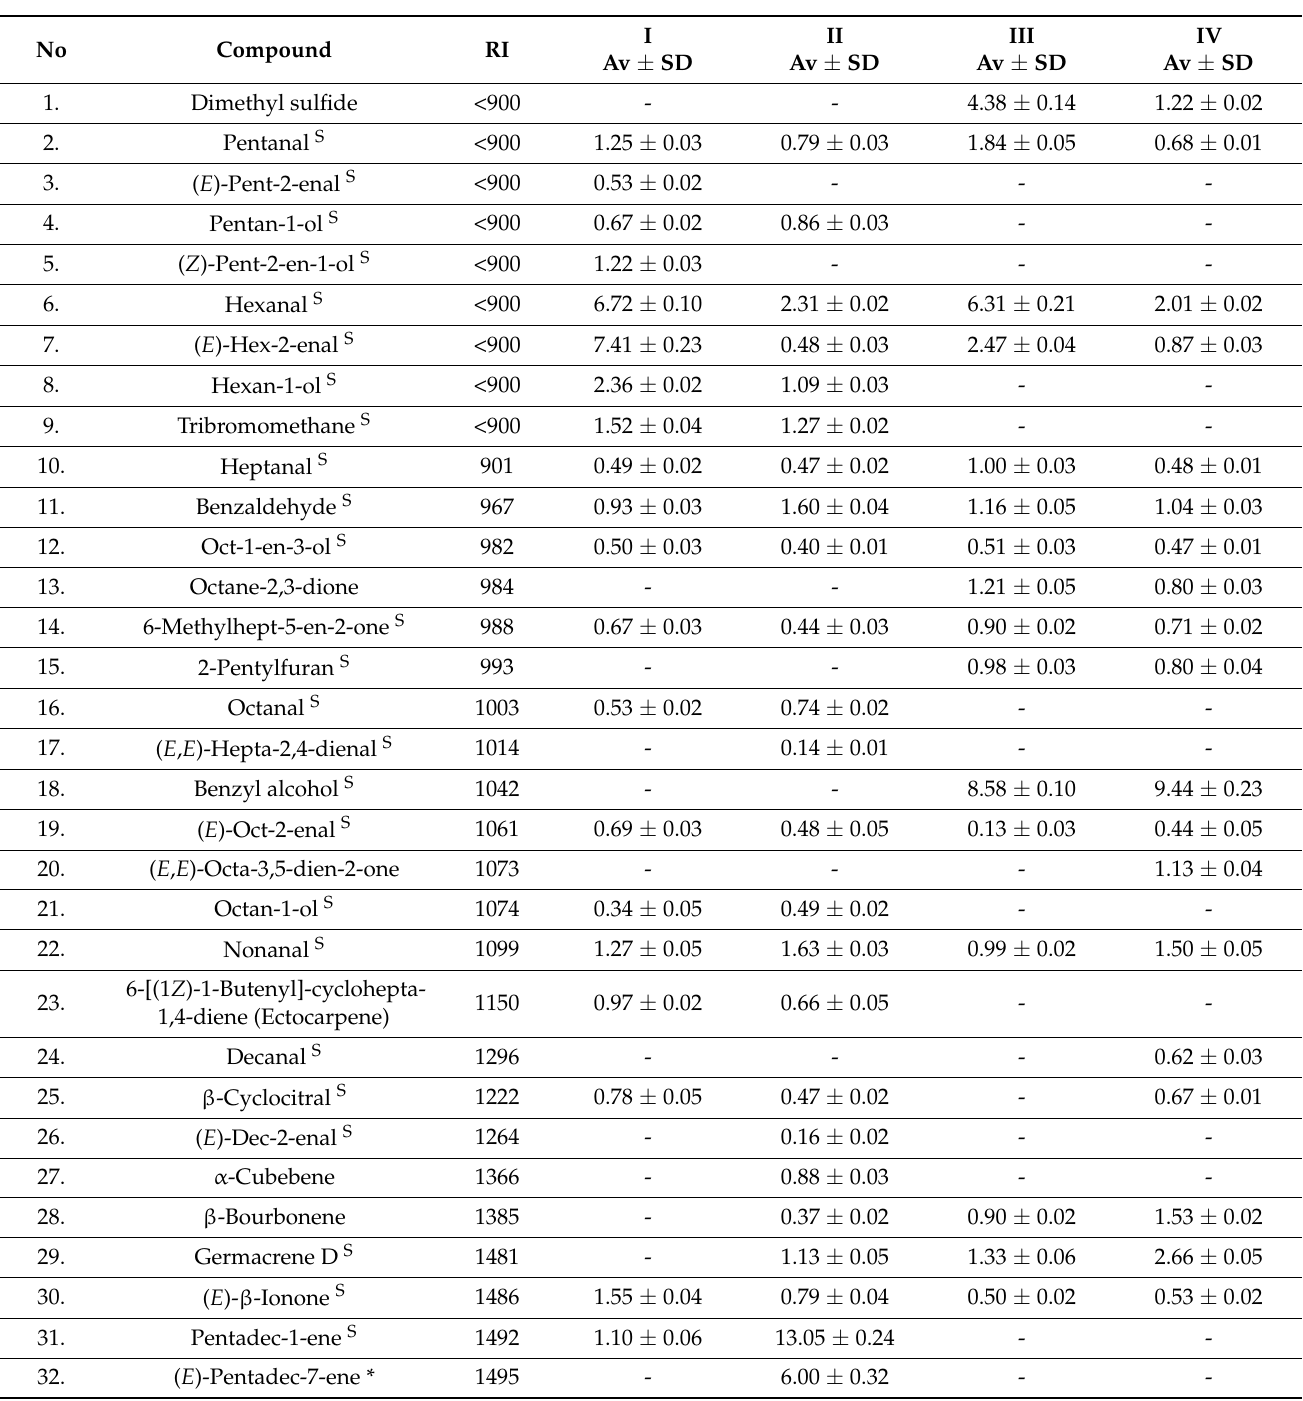
Table 1. The headspace organic compounds of A. rigida determined by HS-SPME/GC–FID/MS (I—fresh sample ex- tracted by DVB/CAR/PDMS fiber; II—fresh sample extracted by PDMS/DVB fiber; III—air-dried sample extracted